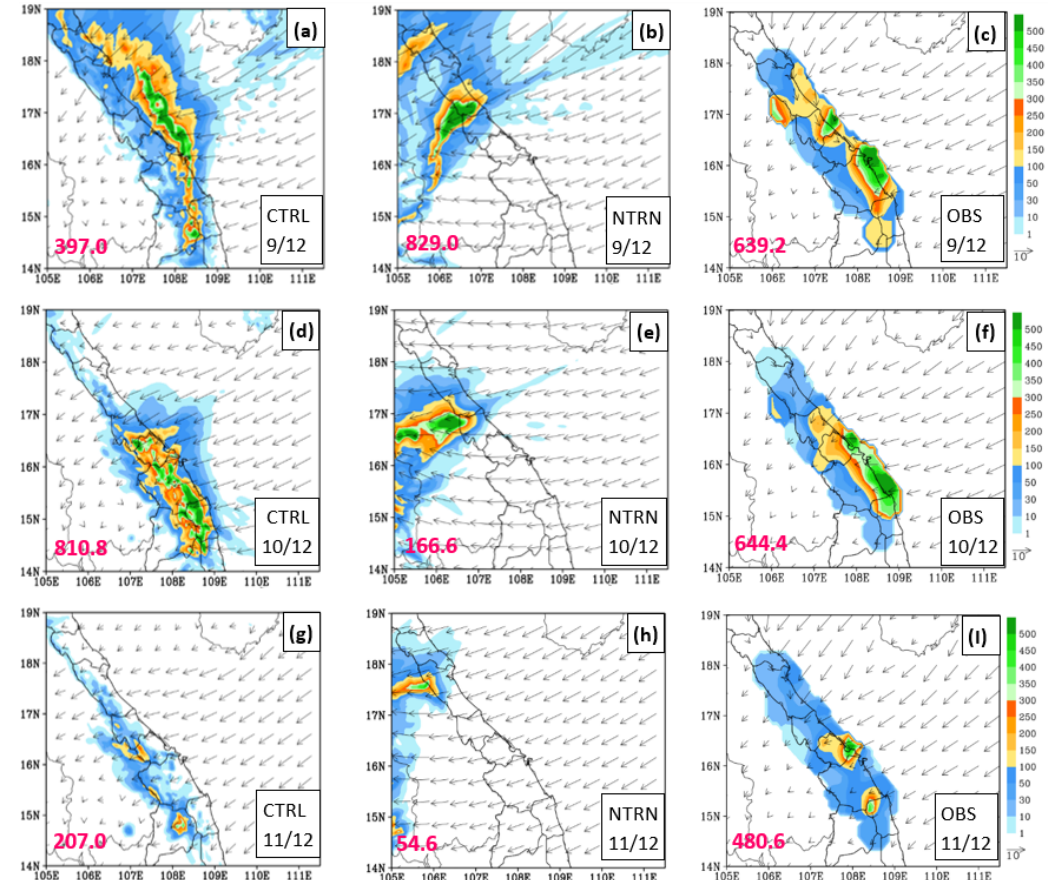
Figure 12. Simulated daily mean surface horizontal wind vectors (ms − 1 , reference length at panels c , f , i ) and 24h accumulated rainfall (mm, color) in CTRL (a, d, g) and NTRN (b, e, h) , and the observed rainfall at gauge sites (OBS), overlaid with the daily mean surface wind vectors derived from the ERA5 data (c, f, i) . From top to bottom they are as follows: (a–c) 9 December, (d–f) 10 December, and (g–i) 11 December 2018. The pink number at the lower left indicates the maximum value of 24h